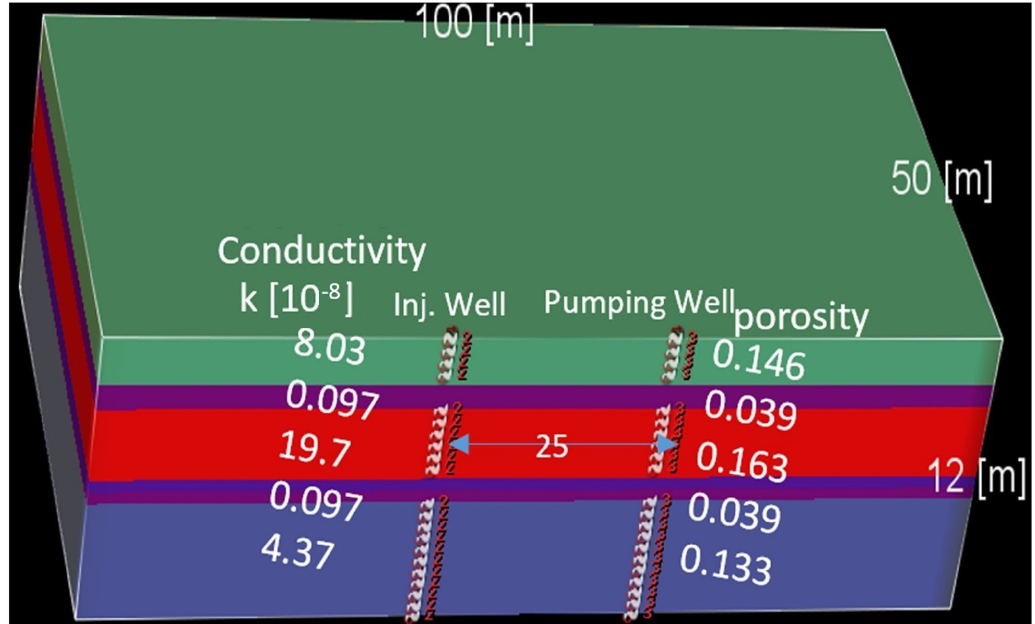
Figure 3. Permeability and porosity distribution over the layers in the 3D model domain. Injection well at the left side is 25 m apart from the pumping well at the right